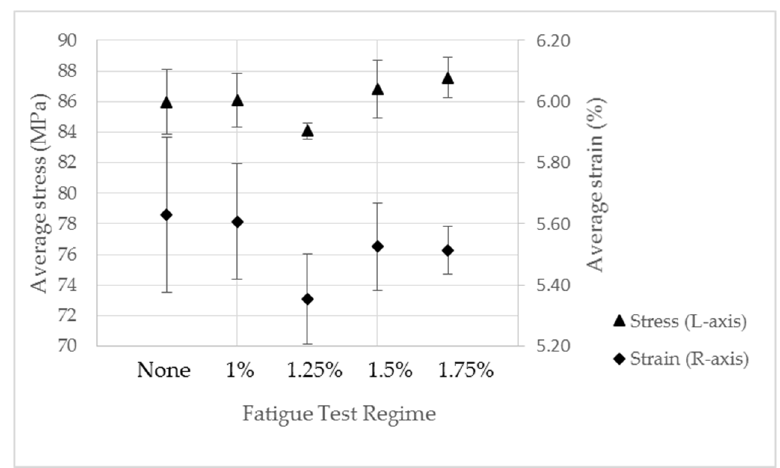
Figure 15. Stress and strain values calculated at the yield point during a tensile test following a 1000 cycle fatigue testing regime at the specified strain. Datapoints are the average of three test samples and error bars represent sample standard deviation.